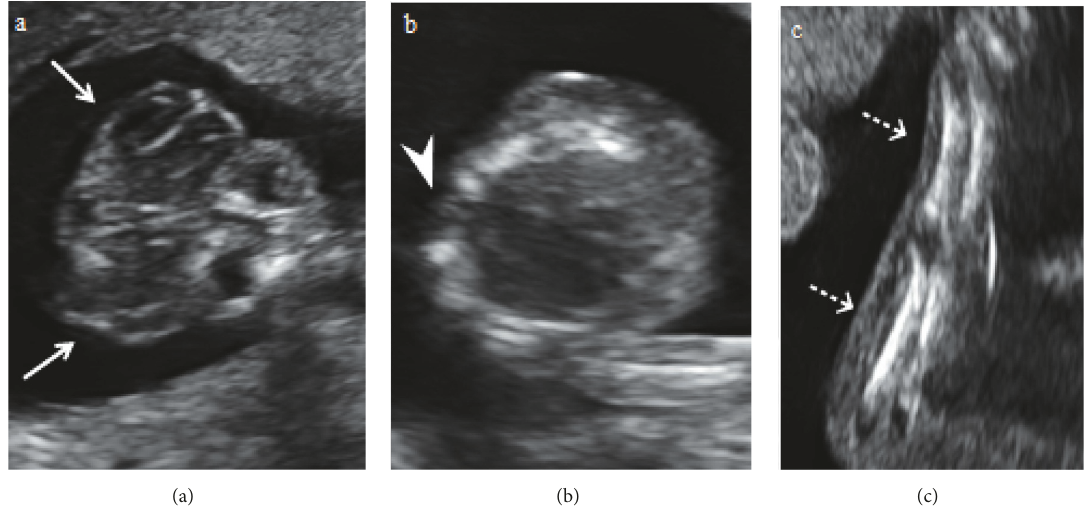
Figure 1: Two-dimensional ultrasound images at 17 weeks of gestation. (1a) The fetus demonstrating typical features of anencephaly (“Mickey Mouse” sign; white arrows). The calvarium is absent, and the brain is “floating” in the amniotic fluid. (1b) Absence of vertebral posterior elements with splaying of the lamina at the thoracic level (white arrowhead). (1c) The lower limbs appeared to be fused together in fixed extension with two femora and two tibiae (white dashed arrows).